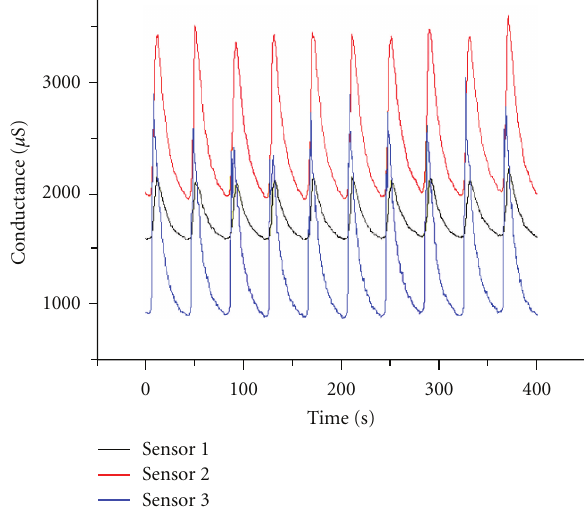
Figure 4: Response of the sensors to ten cycles of exposure/recovery to the volatile compounds of Brazilian walnut ( Ocotea porosa ) at 30 ◦ C. Sensor 1 = PPPX, sensor 2 = PHBPE, and sensor 3 = BHPPV, all doped with CSA.